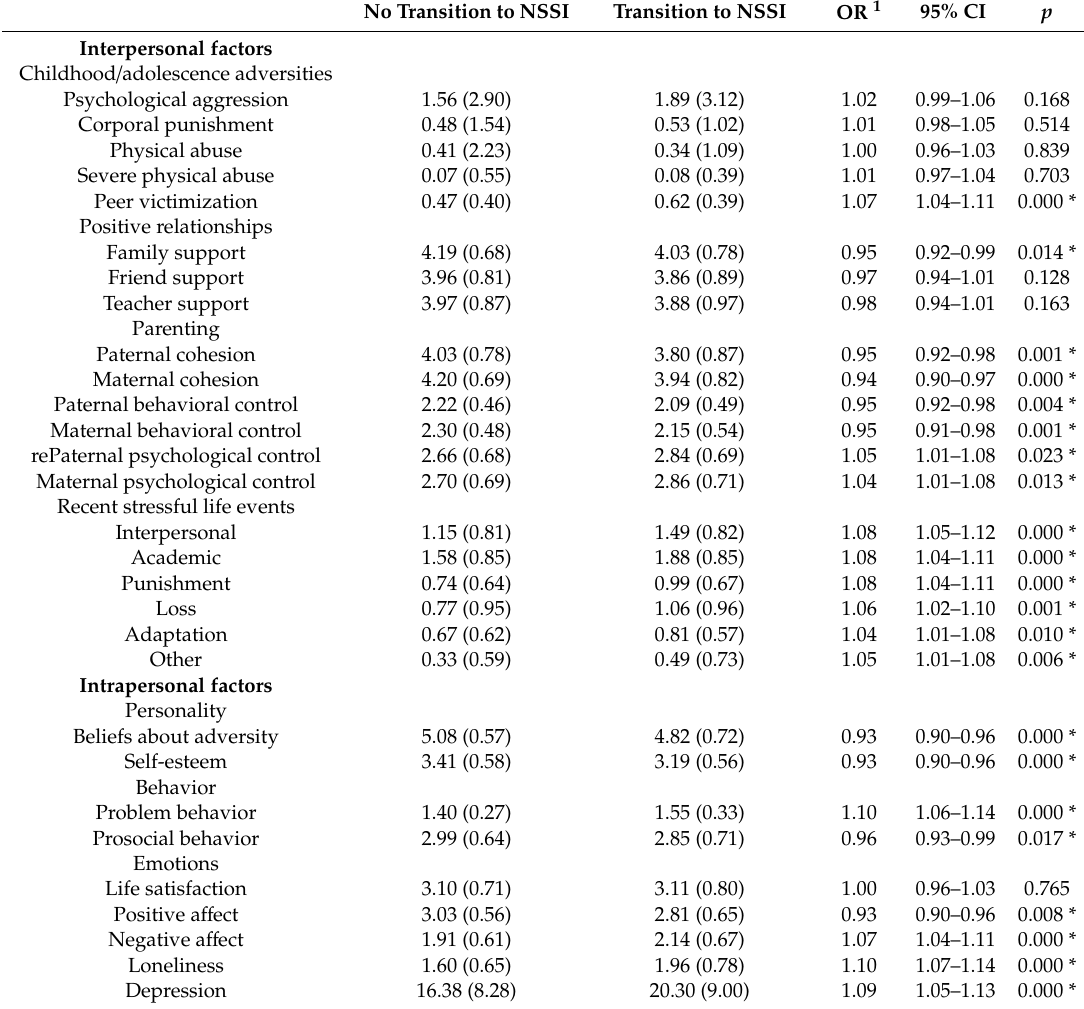
Table 2. Bivariate associations between the predictors and NSSI